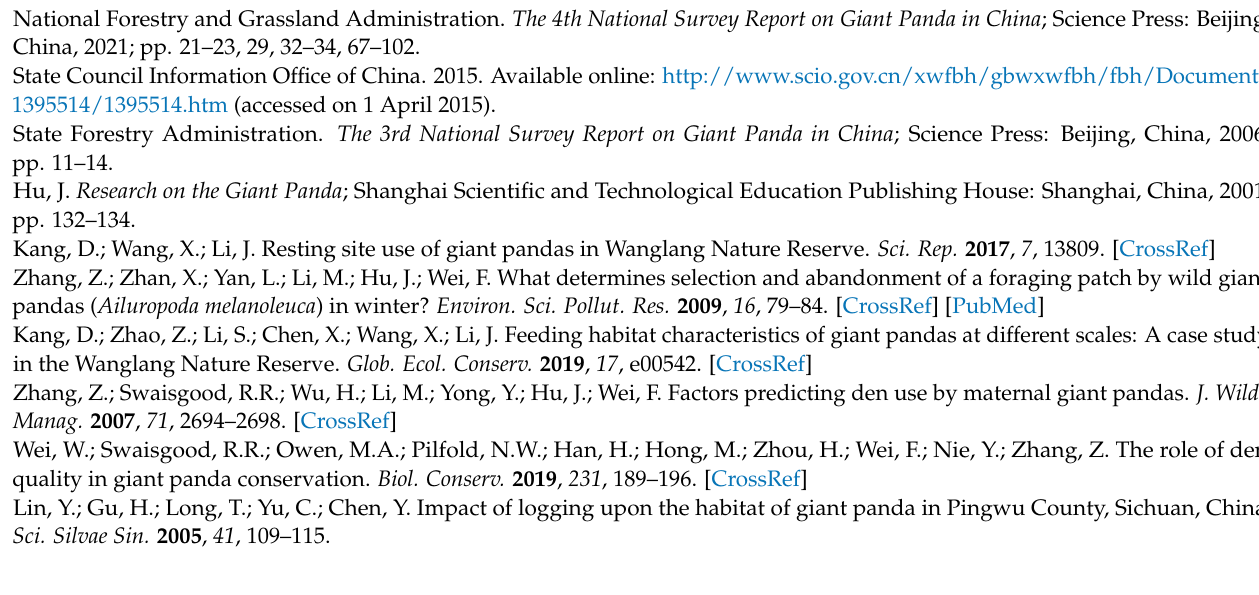
Table S2: Location of path site in this